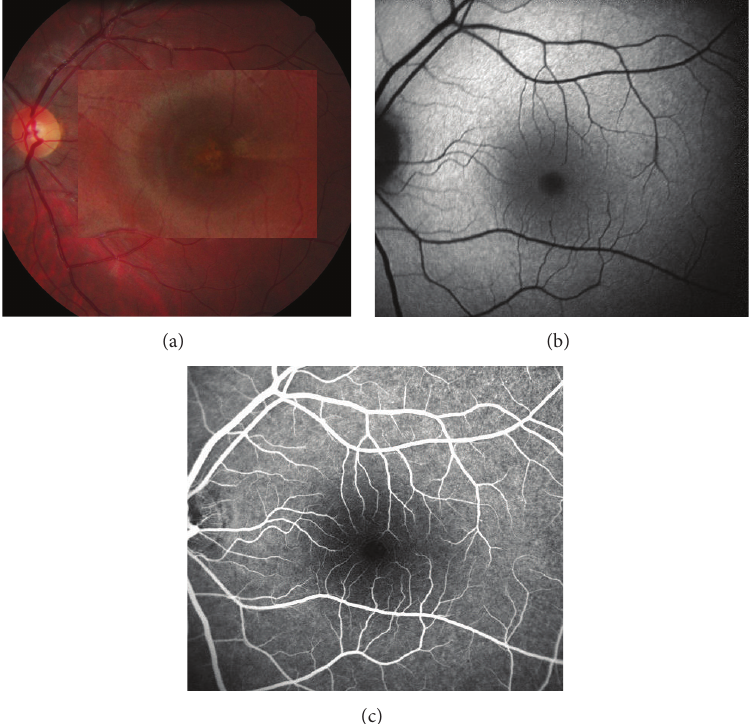
Figure 4: Patient 2, left eye. (a) Color fundus photography showing a yellowish hypopigmented area in the macula. (b) Autofluorescence, and (c) fluorescein angiography, at the initial visit, showing no abnormality.